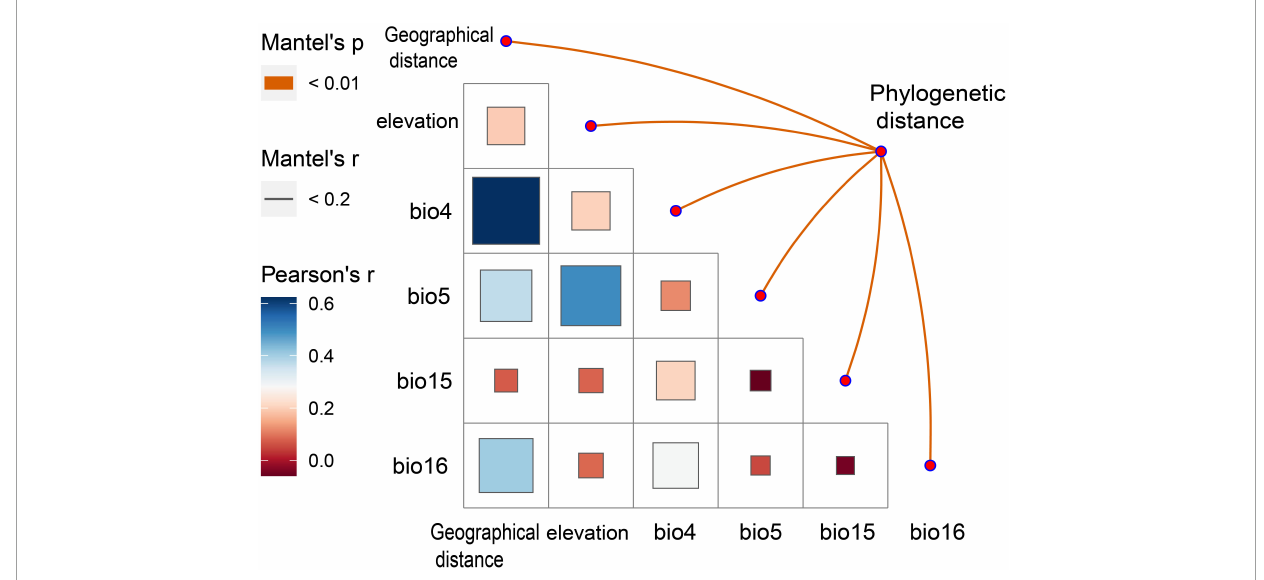
FIGURE4 Mantel Test heat map between phylogenetic diversity of A. oligospora and geographic and climatic factors. bio4 is Temperature Seasonality, bio5 is Max Temperature of Warmest Month, bio15 is Precipitation Seasonality, bio16 is Precipitation of Wettest Quarter.